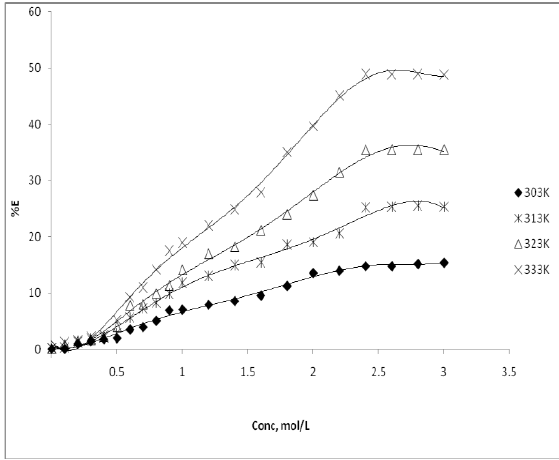
Figure 2. Effect of diethylnicotinamide concentration (C) on percentage extraction (%E) of